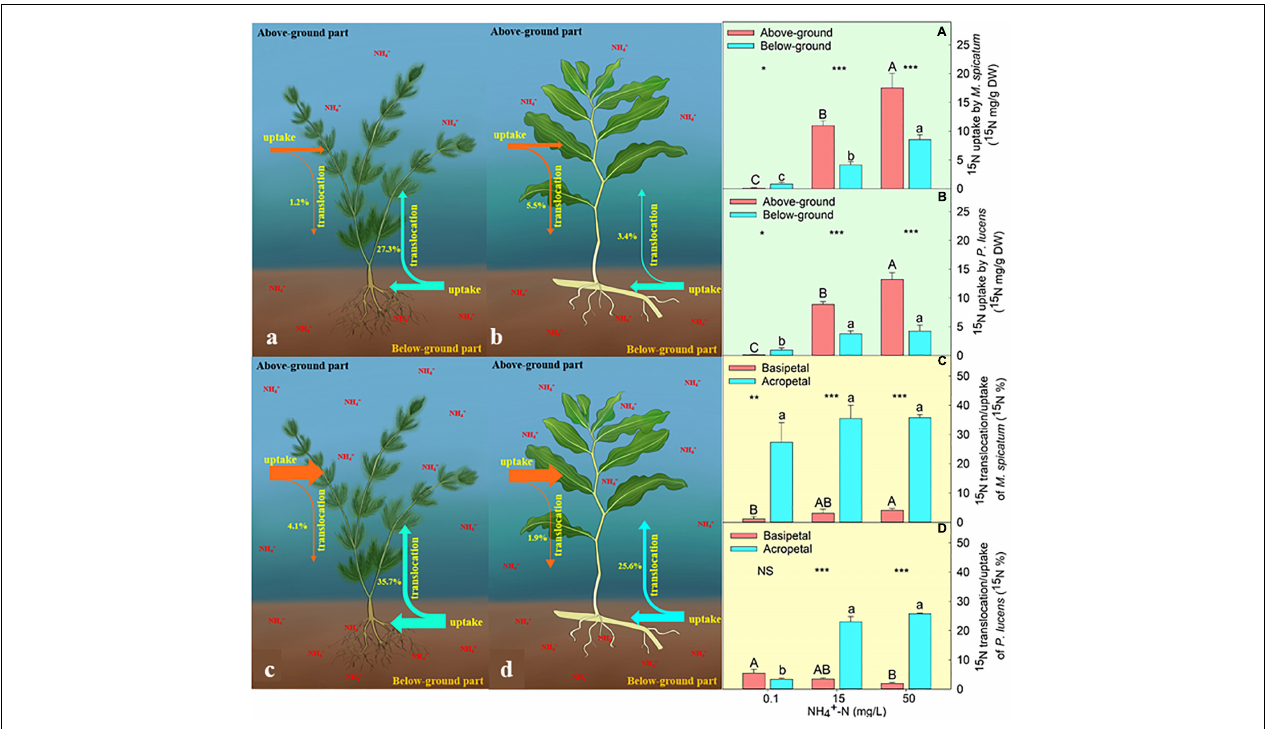
FIGURE 1 | Characteristics of 15 N uptake and translocation in plants. Schematic diagram of 15 N uptake and translocation of M. spicatum and P. lucens under normal (a,b) and high (c,d) [NH 4 + − N]. The effects of different [NH 4 + − N] on the 15 N uptake of M. spicatum (A) and P. lucens (B) through the above-ground part (red bar) and the below-ground part (blue bar) and 15 N translocation of basipetal (red bar) and acropetal (blue bar) of M. spicatum (C) and P. lucens (D) . Different letters represent significant differences ( p < 0.05). Statistical Student’s t -tests are shown, * p < 0.05, ** p < 0.01, *** p < 0.001, NS: no